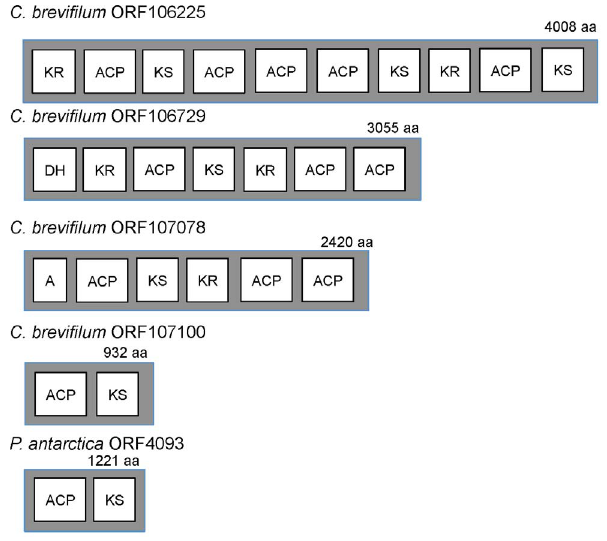
Figure 3. Putative domain organization and length of polyke- tide synthase sequences in genes containing more than one domain, as annotated by the NRPS-PKS tool. KR: ketoreductase, ACP: acyl carrier protein, KS: keto-synthase, DH: dehydratase, A: adenylation.